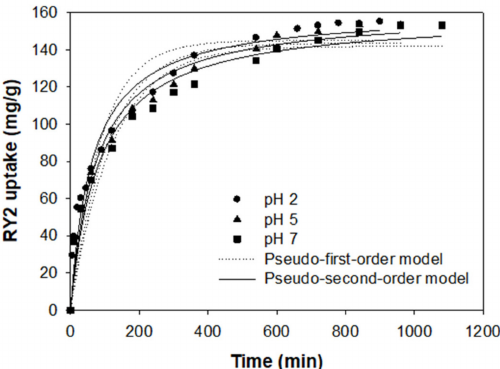
Figure 5. Kinetics of RY2 adsorption by PEI/PVC-CF at different pH values (Experimental conditions: m = 0.02 g, V = 30 mL, C i = 100 mg/L, and temperature = 25 ◦